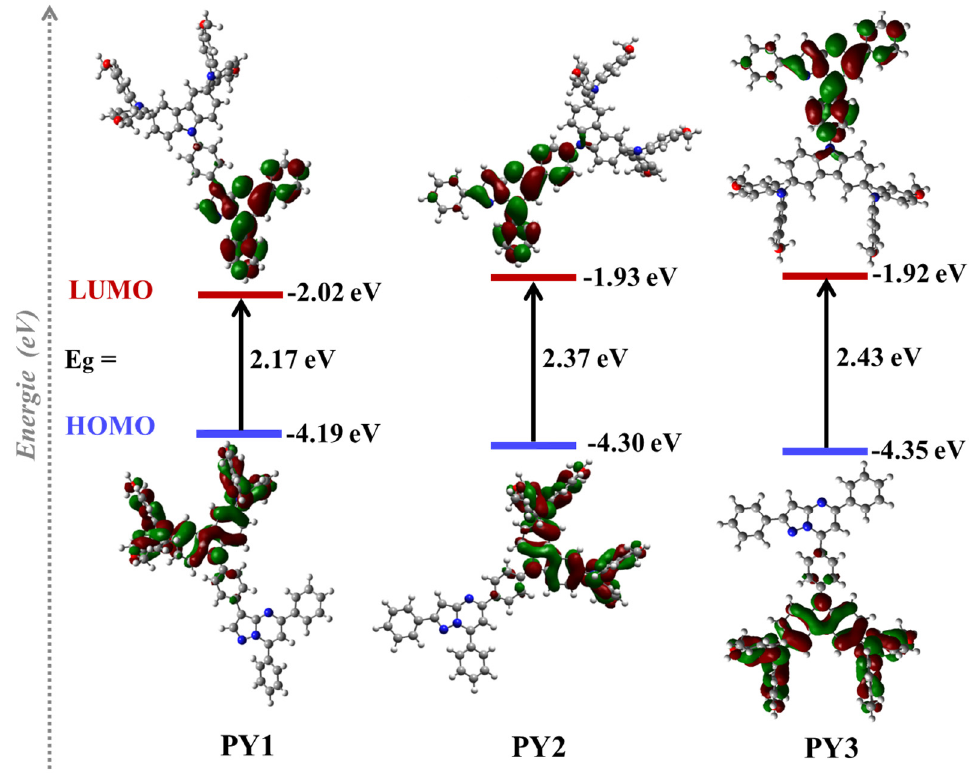
Figure 4. Optimized structures, HOMO and LUMO energy levels, energy gaps, and electron distri- butions of PY1 , PY2 and PY3 molecules calculated by DFT calculations at the B3LYP/6-31G level.